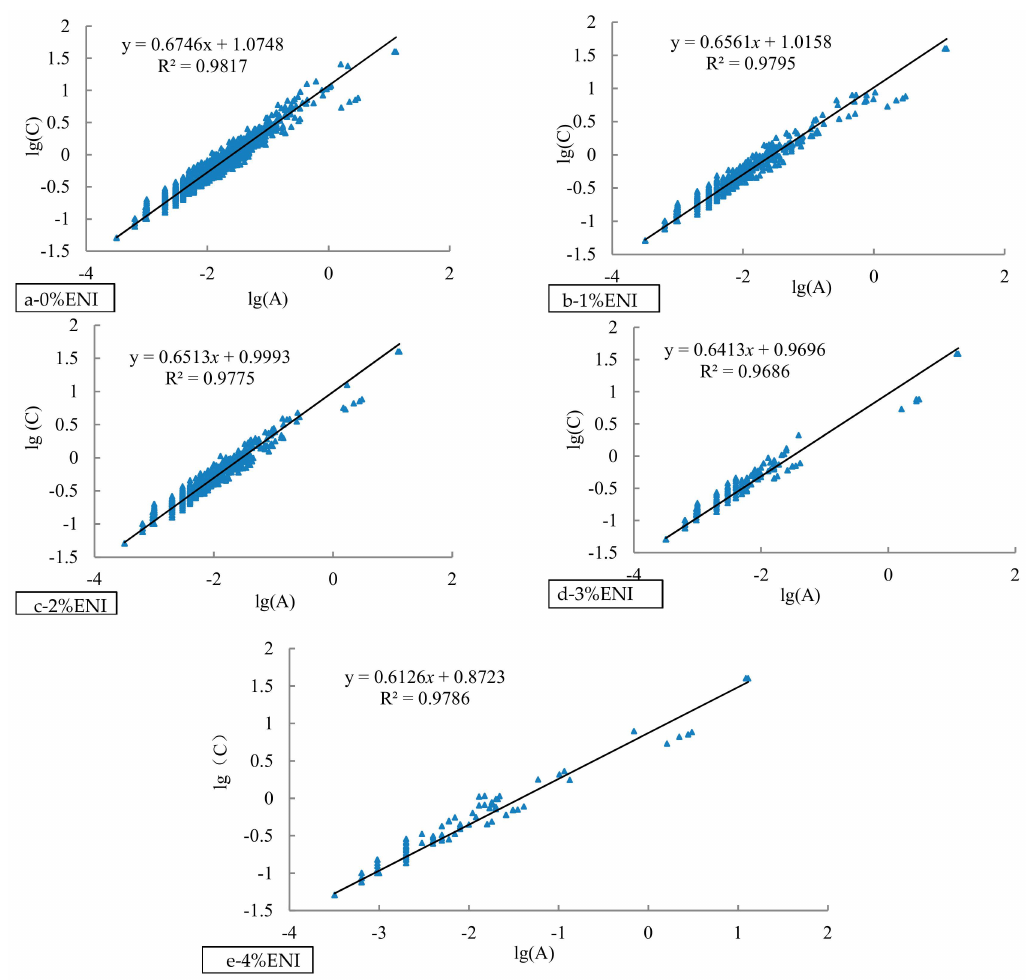
Figure 5. Shale sample fractal curve fitting result chart. ( a ) 1% ENI; ( b ) 1% ENI; ( c ) 2% ENI; ( d ) 3% ENI; ( e ) 4%